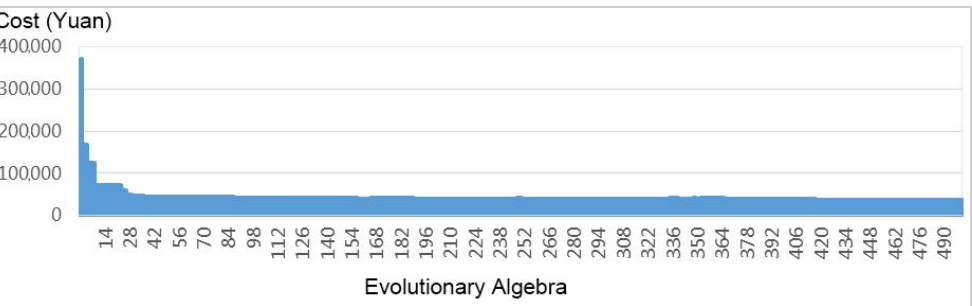
Figure 5. Evolutionary process of maxima in the Pareto-optimal solution of pollution control objectives.